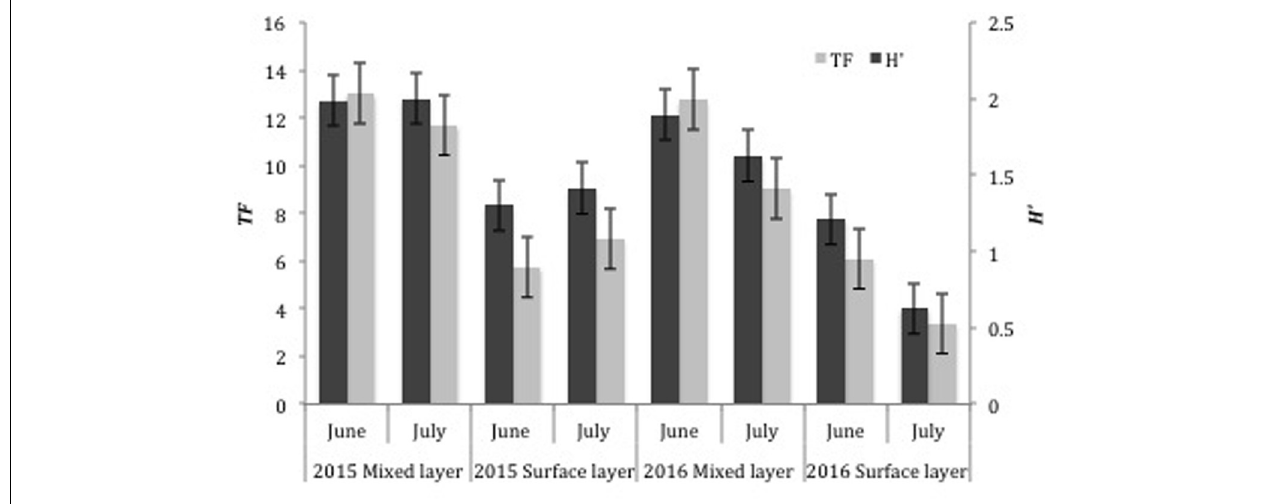
FIGURE 2 | Comparison of taxonomic richness ( T F ) and Shannon diversity ( H’ ) of all ichthyoplankton collected in the surface (0–1 m with neuston tows) and mixed layer samples (0–100 + m with oblique bongo tows) in 2015 and 2016 in the Northern Gulf of Mexico. Error bars represent standard error of the mean.